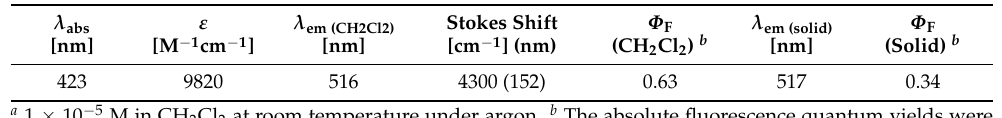
Table 2. Photophysical data for 3 a